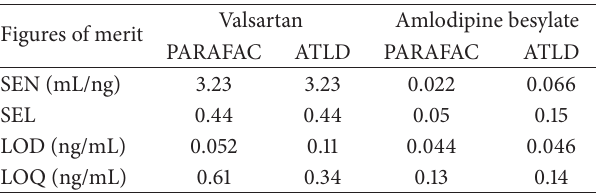
Table 5: Figures of merit of valsartan and amlodipine besylate in human plasma using two algorithms. Figures of